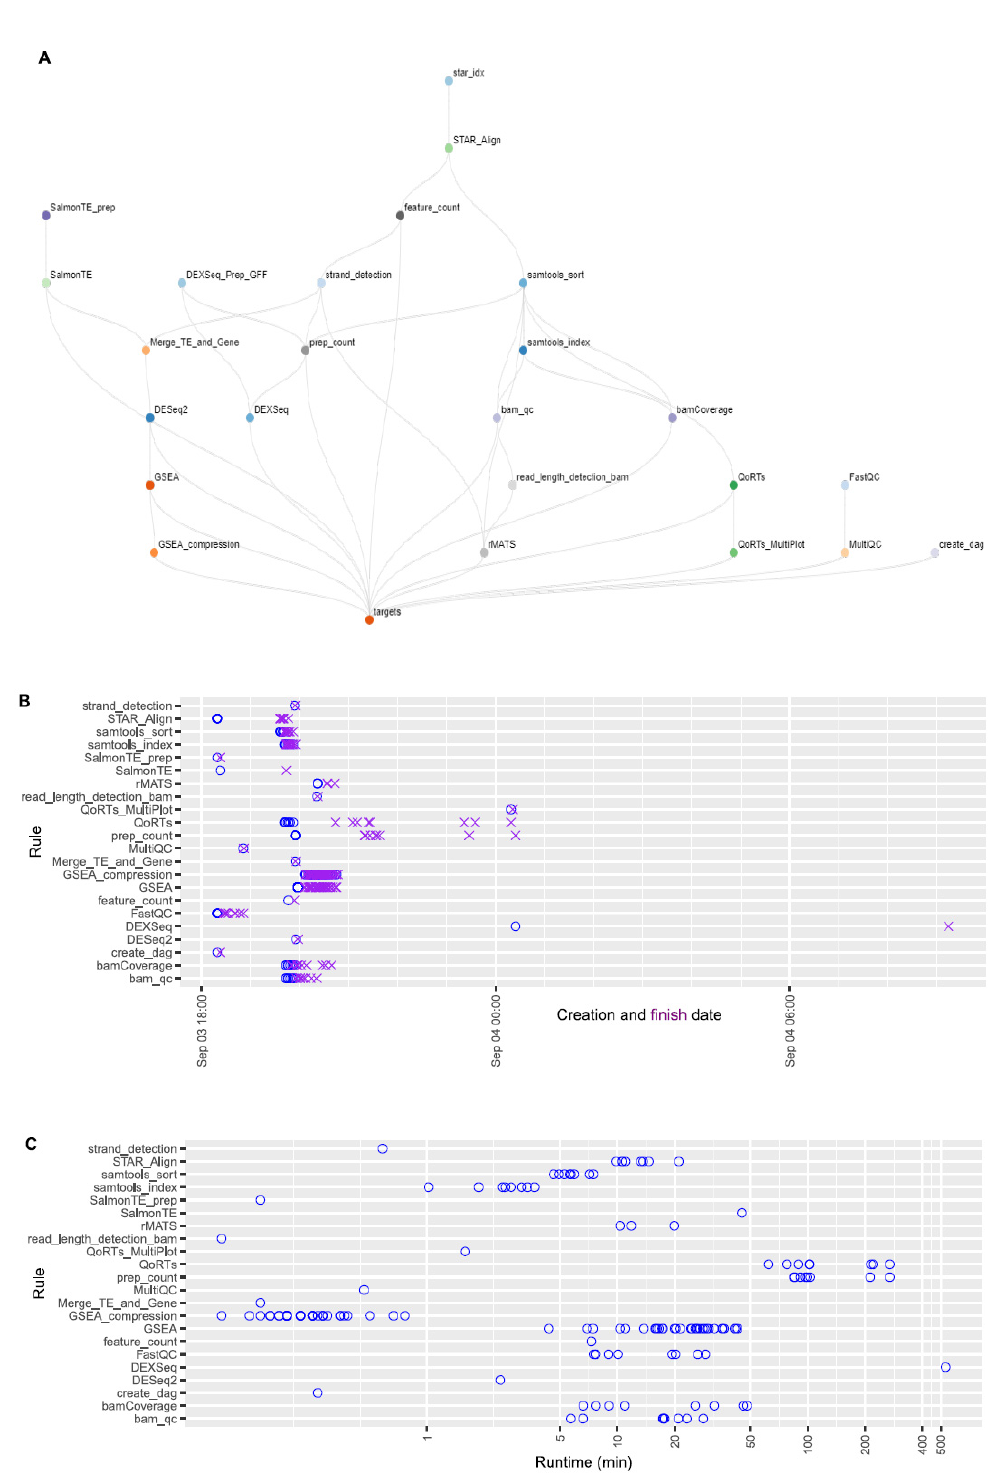
Figure6. ThestructureoftheOneStopRNAseqworkflowandruntimestatisticsofeachjob.( A )Adirectional acyclic graph (DAG) showing the structure of the workflow. Jobs at lower levels depend on connected jobs at higher level and the workflow is executed from the top to the bottom following the specified job dependencies. ( B ) Creation and finish dates of each job. Blue circles indicate job creation dates and purple crosses show job finish dates. ( C ) Runtime of each job in